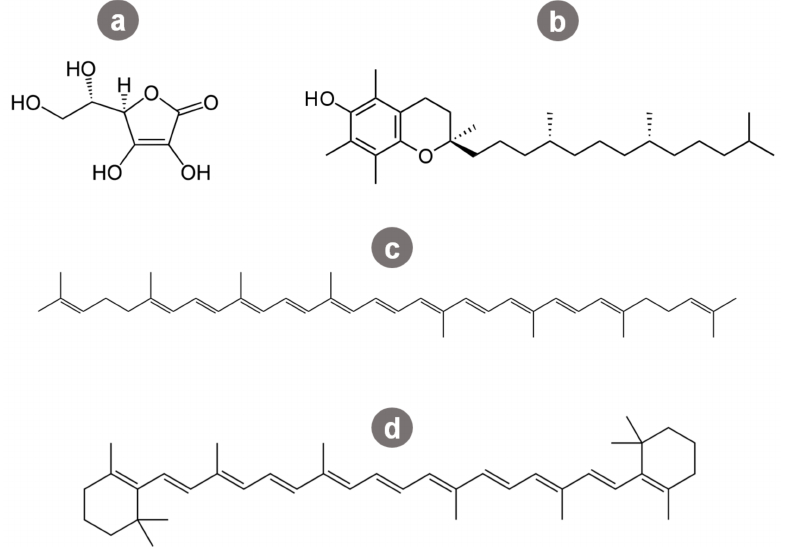
Figure 2. Chemical structure of main bioactives extracted from tomato by-products: ( a ) vitamin C; ( b ) vitamin E; ( c ) lycopene; ( d ) β